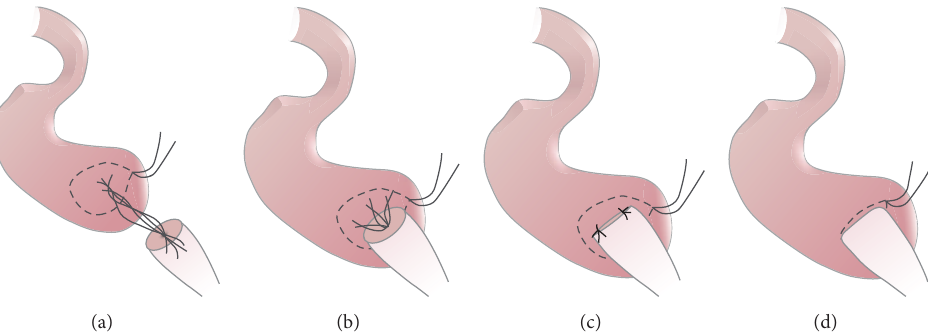
Figure 4: A diagram showing steps of the procedure. (a) A purse string is performed around a 5 mm stab incision in the posterior wall of stomach; then four sutures are performed between the pancreatic duct and gastric mucosa. (b) Tightening duct to mucosa sutures. (c) Sutures are taken between pancreatic capsule and seromuscular layer of the stomach. (d) Invagination of the pancreatic remnant into posterior wall of the stomach and tightening of the purse string